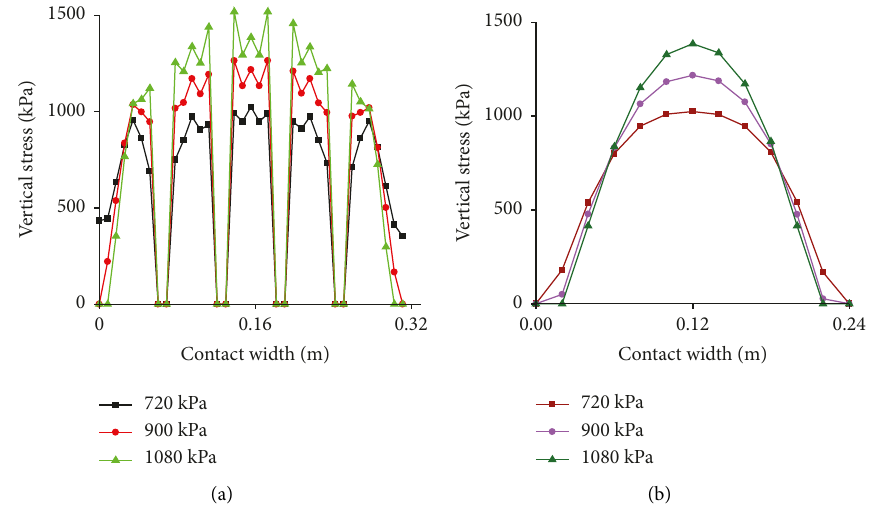
Figure 10: Vertical stress under different tire pressures: (a) width and (b)